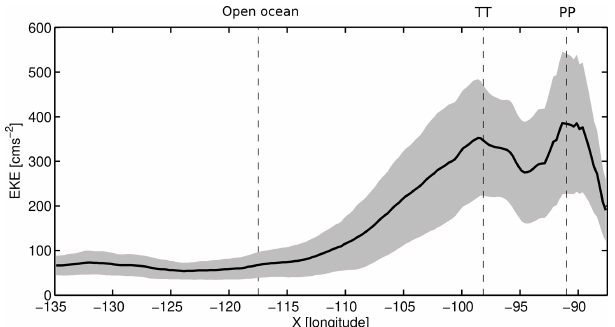
Figure 4. Zonal variability of meridionally averaged EKE between 9 and 16 ◦ N. The values are then averaged over the period of study, from 1993 to 2016. The shaded area shows the ± 0.5 SD, averaged over the whole period at each position. The dashed lines show the EKE of the ocean circulation in the open ocean and two local max- ima driven by TT and PP gap winds, respectively. The continental shelf is on the right side of the